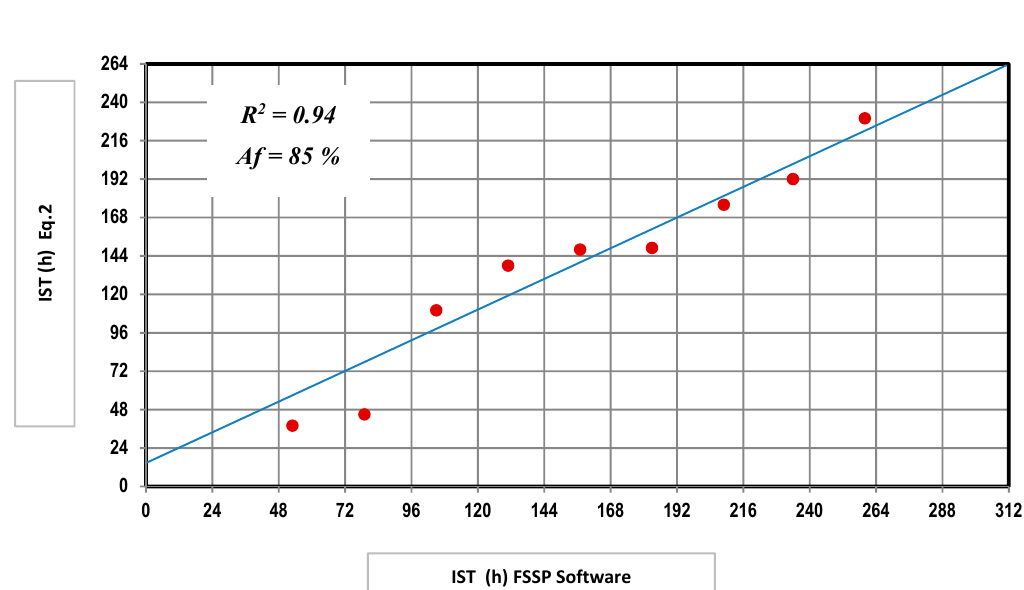
Figure 5. Comparative study between the results for Equation (2) (IST) and bacterial growth according to FSSP software. IST (h): Ice storage time of sea bream in hours; Af (%): Accuracy factor. ( A ) Modelling for Bacterial Count According to FSSP Software; ( B ) IST: Equation (2) Vs. FSSP.